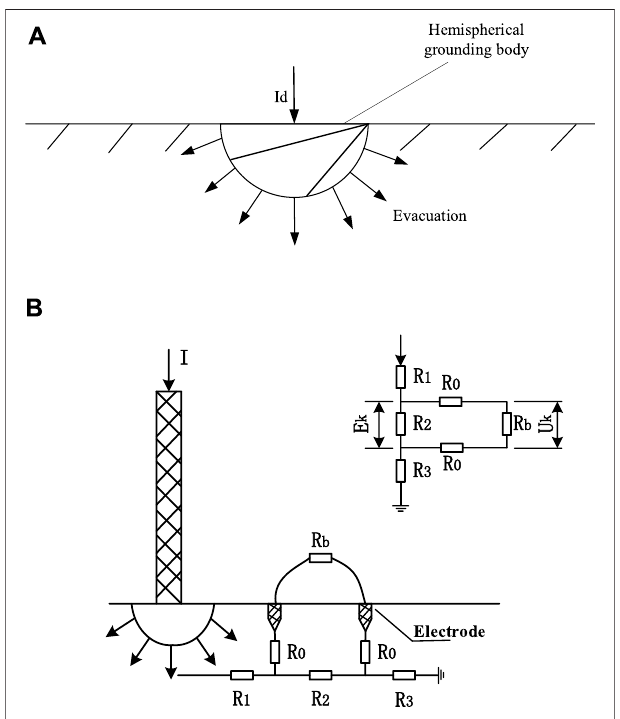
FIGURE 1 | Energy dissipation and extraction. (A) Ground current dissipation and (B) schematic diagram of leakage energy extraction.